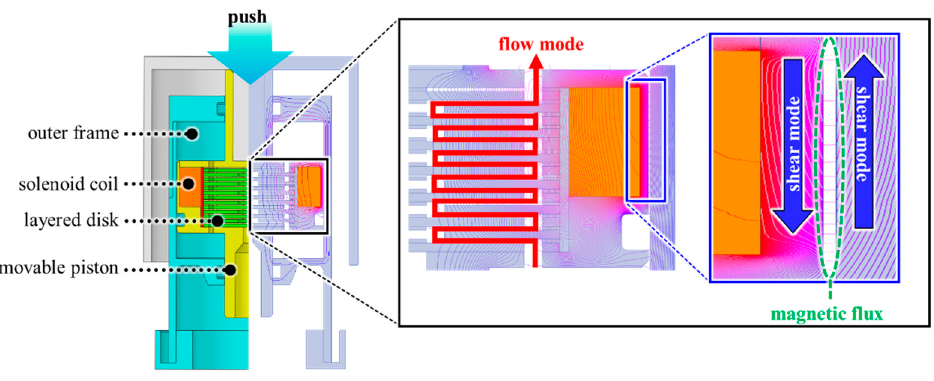
Figure 5. FEM simulation of the proposed design.